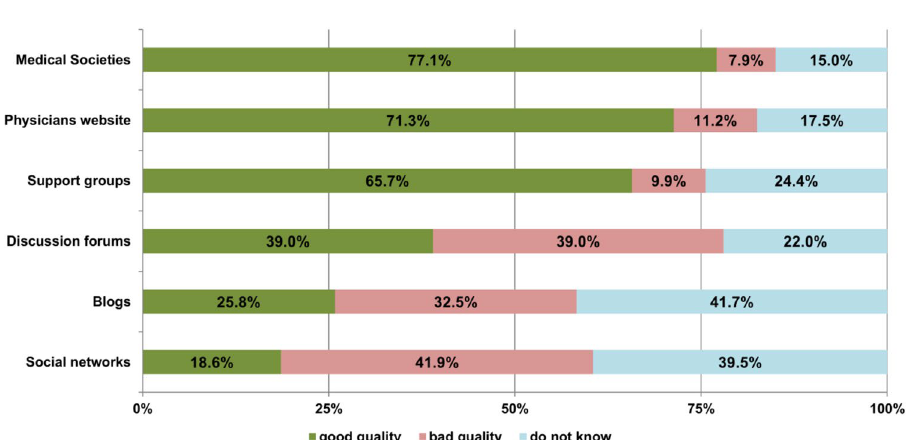
Figure 3. The patients` assessment of the quality of online sources for health related information in % (answers given by the 234 responders).